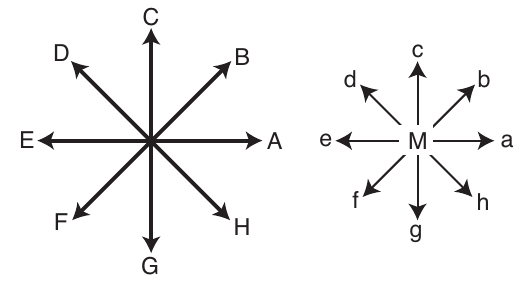
Figure 2. Accuracy rate and mean reaction times for responses